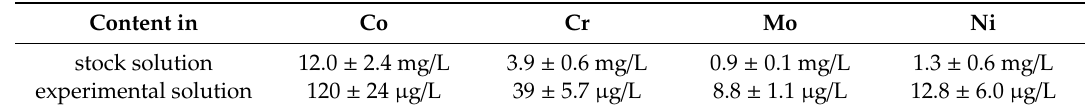
Table 2. Total ion